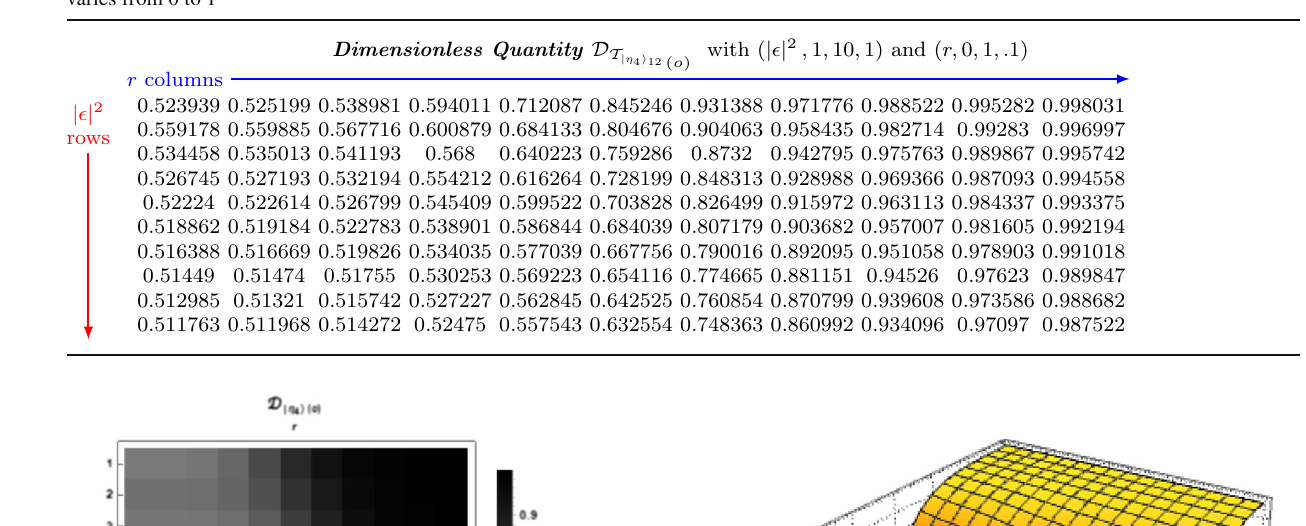
13 showing numerical tabulated in the form of a values of D T | η 4 (cid:2) 12 ( o ) matrix for same range of coherent and squeezing parameters.